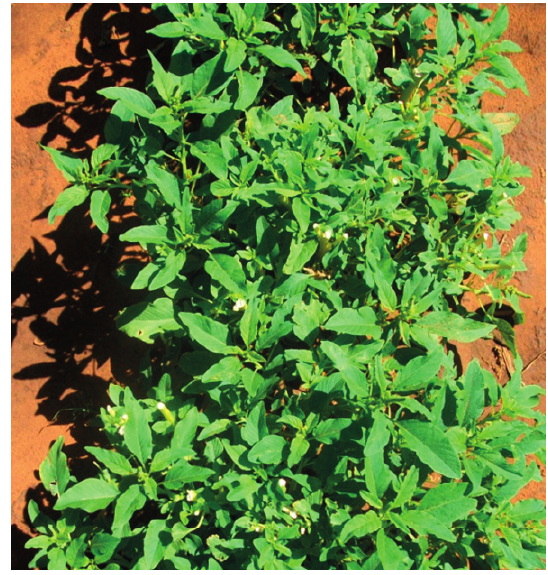
Figure 7. Amaranthus cruentus . Source [10].